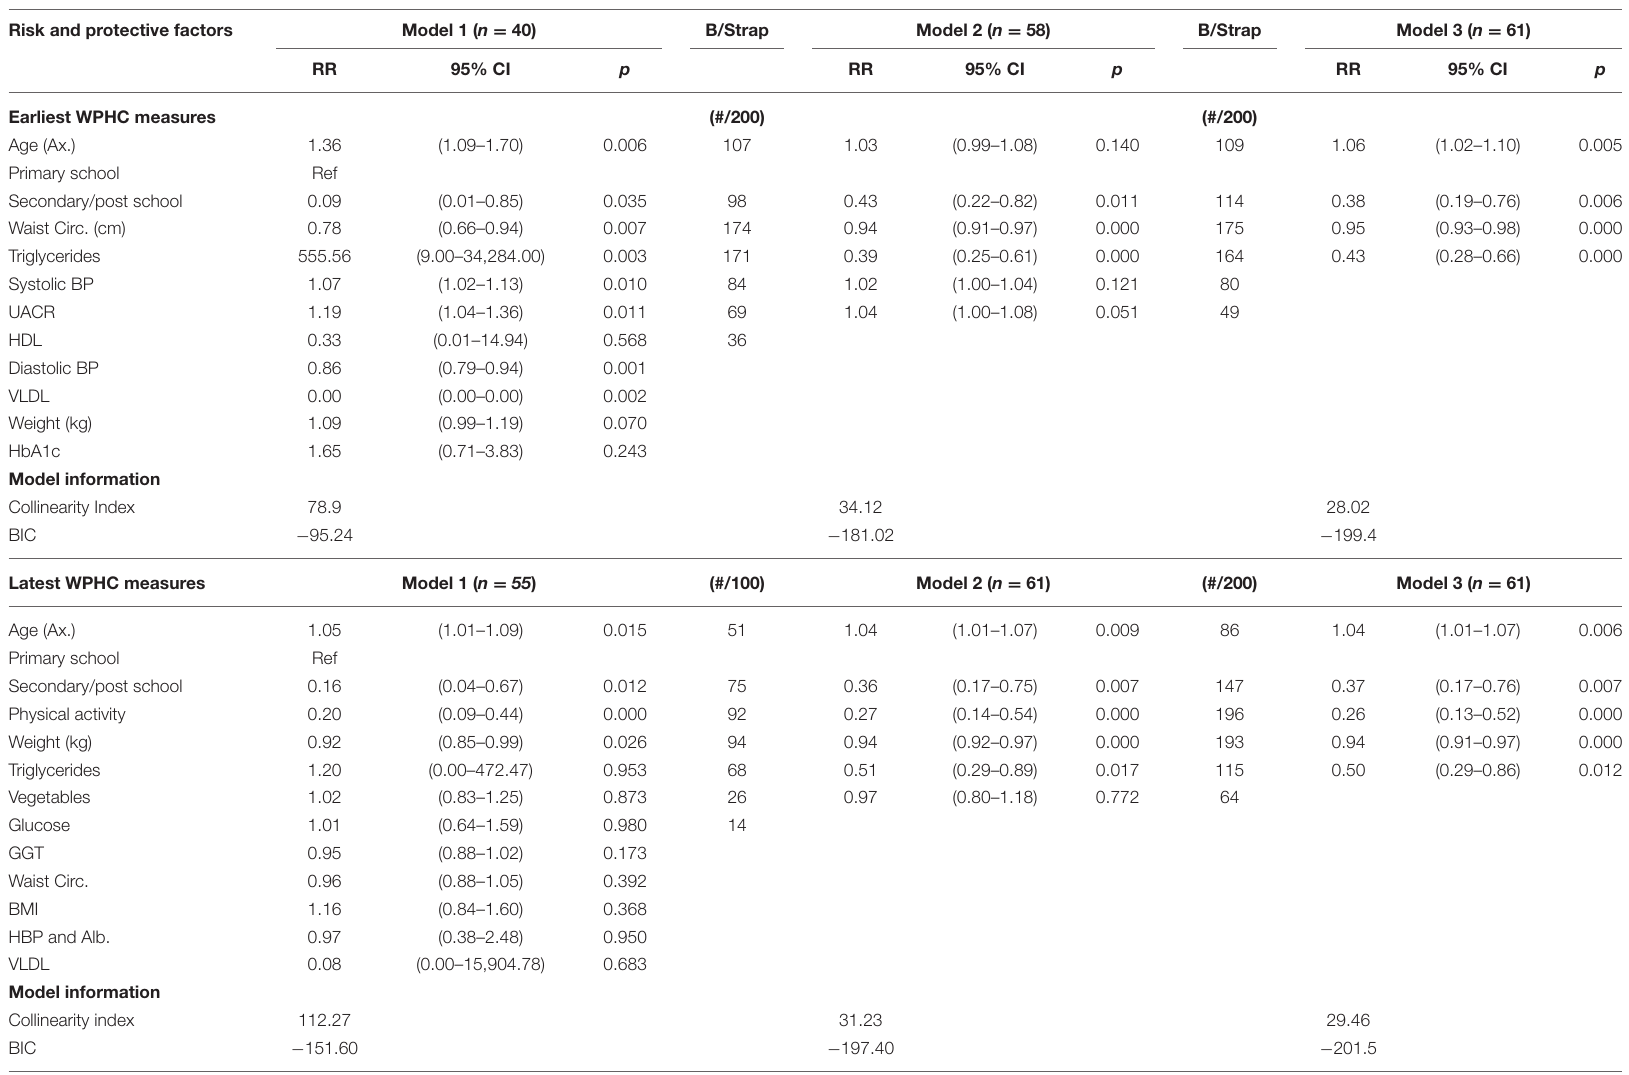
TABLE 3 | Multivariate risk ratios from generalized linear modeling, with bootstrapping variable selection, for earliest and latest recorded risk and protective factors for Cognitive Impairment Not Dementia (CIND) or dementia, among 64 Aboriginal and Torres Strait Islander residents who participated in the Well Person’s Health Check (WPHC) (1998/2000,